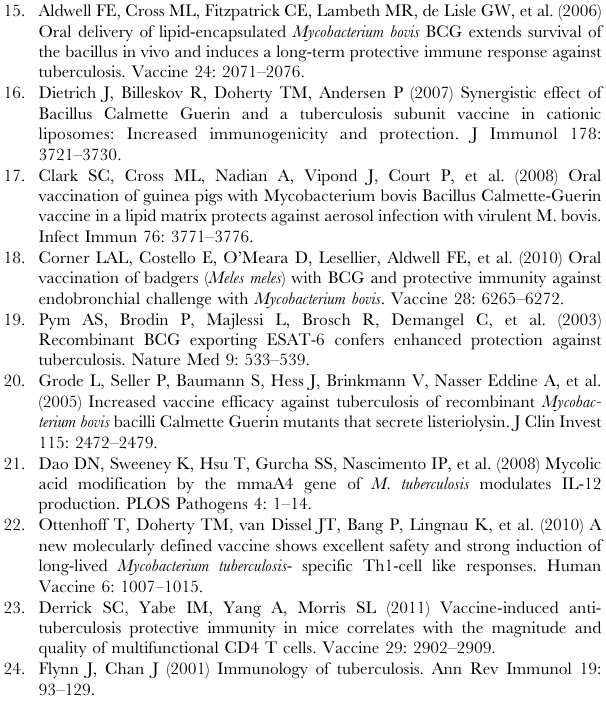
Figure S1 To verify the multifunctional T cell frequency results that were observed in the initial experiments, a separate group of mice were vaccinated with BCG or BCG-A4/Adj and the frequencies (%) of CD4 (A) or CD8 (B) multifunctional T cells producing IFN c and TNF a , IFN c and IL-2, TNF a and IL-2 or all three cytokines (TP) were measured by flow cytometry. Splenocytes from four unchallenged mice per group were analyzed separately. *Signif- icant differences relative to naı¨ve controls, p , 0.05. # Significant differences relative to BCG controls, p , 0.05. (TIF) Figure S2 The integrated MFI (iMFI) values for (A) IFN c and (B) TNF a were calculated by multiplying the MFI values times the frequencies of IFN c or TNF a single positive, IFN c /TNF a double positive or triple positive (IFN c /TNF a /IL-2) CD4 T cells. iMFI values were derived from stimulated splenocytes from BCG, BCG/Adj. BCG-A4 or BCG-A4/Adj vaccinated mice. # Significant differences relative to BCG controls, p , 0.05. (TIF) Figure S3 The iMFI values for (A) IFN c and (B) TNF a are shown for IFN c or TNF a single positive, IFN c /TNF a double positive or triple positive (IFN c /TNF a /IL-2) CD8 T cells using stimulated splenocytes from BCG, BCG/ Adj. BCG-A4 or BCG-A4/Adj vaccinated mice. # Significant differences relative to BCG controls, p , 0.05.